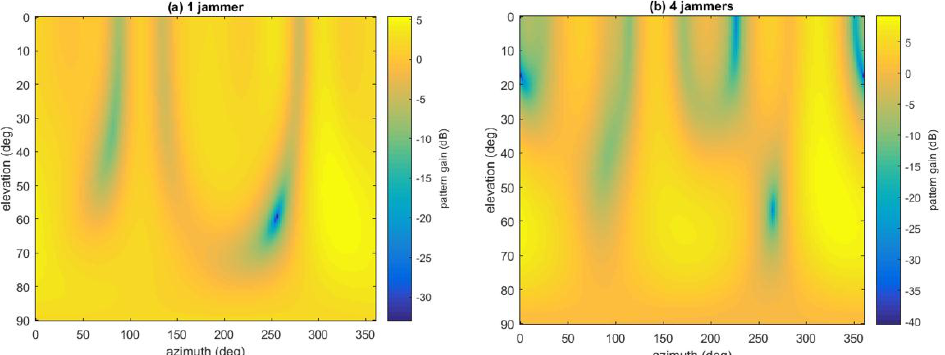
Figure 21. Antenna pattern of SAP nulling in Jamming Scenario 2.